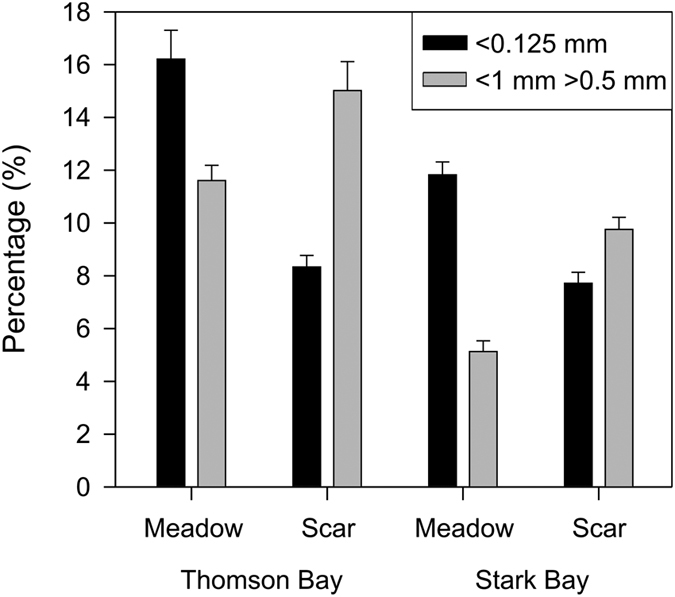
Sediment grain-size fractions, expressed as a percentage of the total sediment dry weigh <1 mm in diameter, in the sediment cores from seagrass and mooring-induced scars at Thomson Bay and Stark Bay.Sediments were classified as coarse sand (<1 mm and >0.5 mm) and very fine sand plus silt and clay (<0.125 mm).